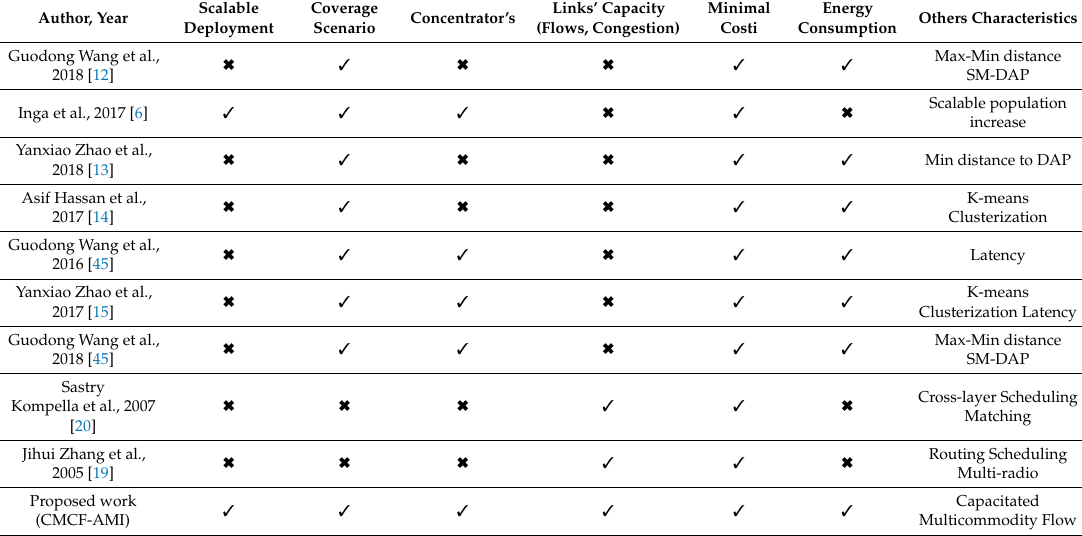
Table 1. Summary: comparison of the results with other methods. SM, smart meter; CMCF-AMI, capacitated multicommodity flow for advanced metering